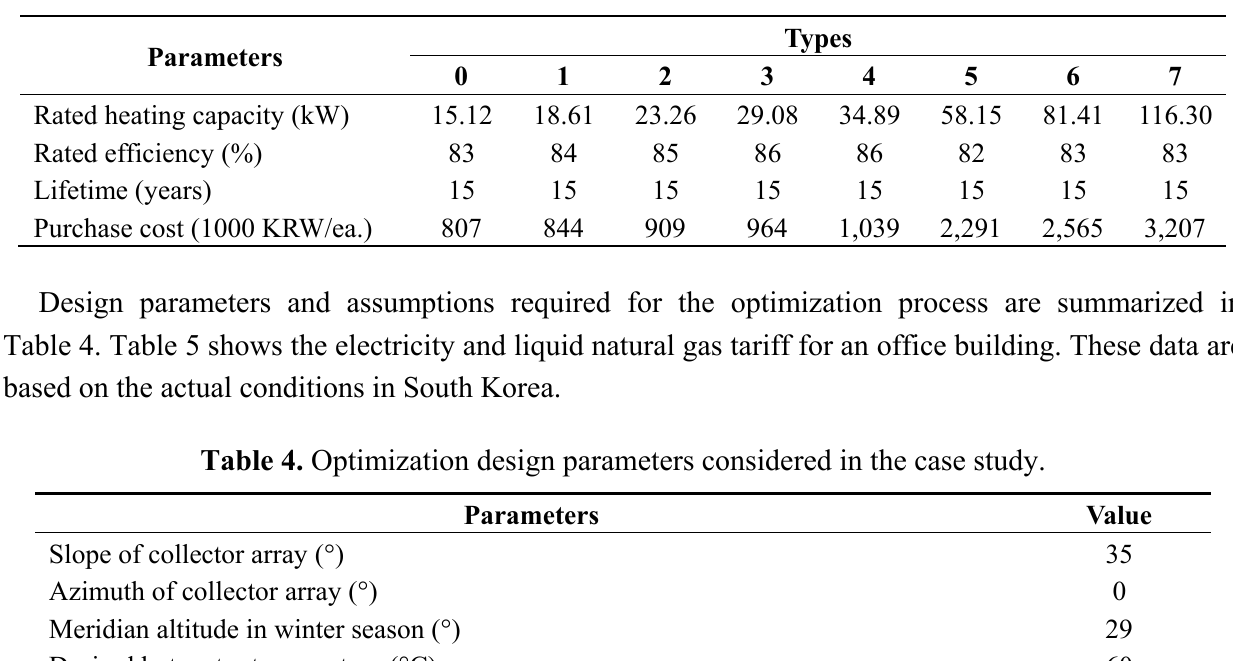
Table 3. Technical and economic parameters of the auxiliary heaters for the case study.